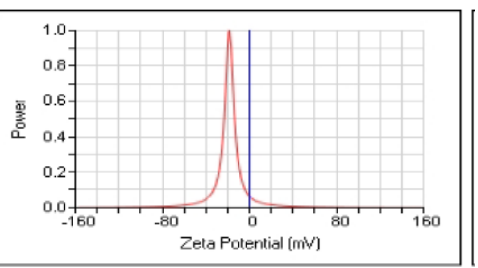
Figure 5. Zeta potential for NE9 formula